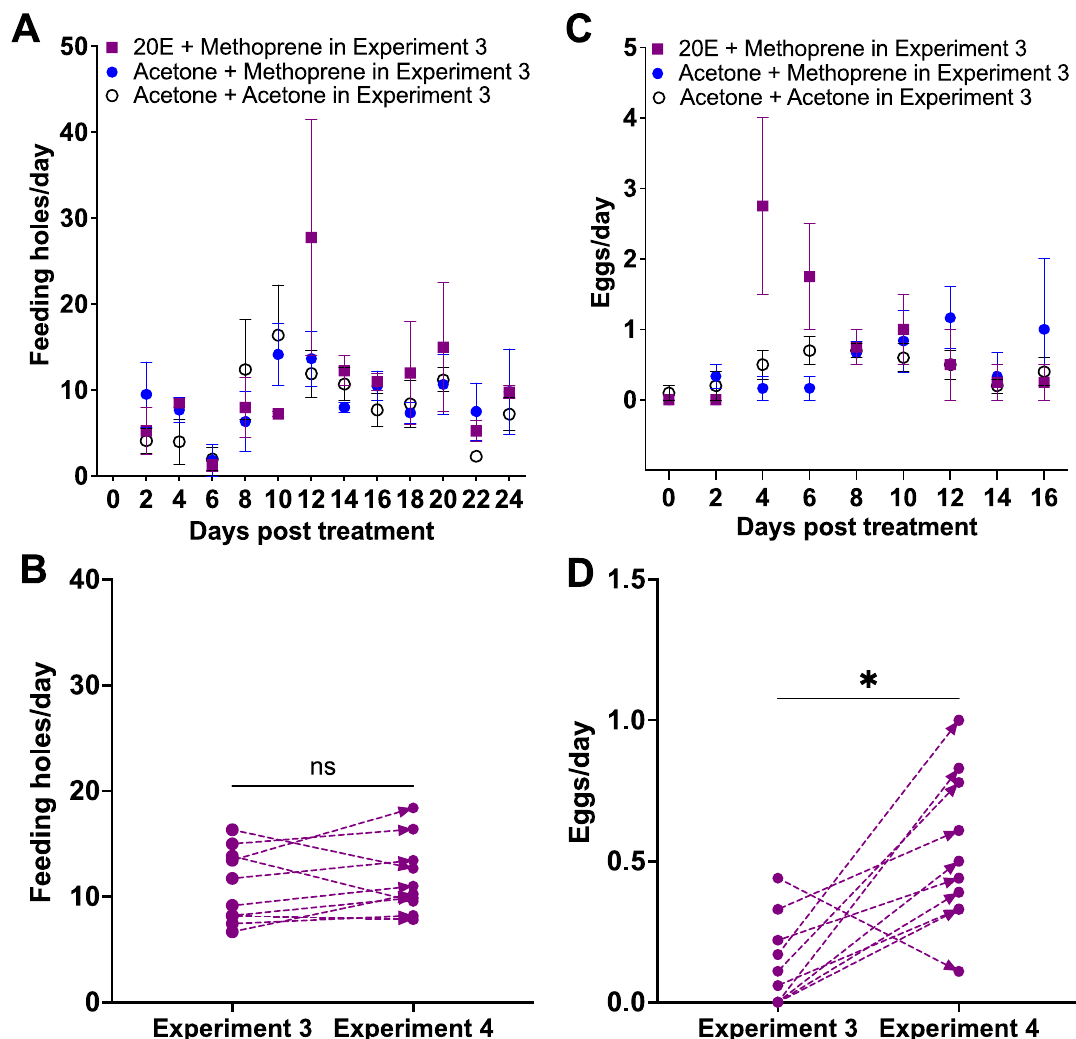
Figure 4. The effect of applying 1 µ g of 20E followed by 1 µ g of methoprene on underperforming (laying < 1 egg per day) and unresponsive females used in Experiment 3 (Figure 3). Daily mean number ± SE of feeding holes ( A ) and individual response of feeding holes for each female weevil ( B ) in Experiment 3 and treated with 20E and methoprene in Experiment 4; daily mean number of eggs ± SE ( C ) and individual response of eggs for each female weevil ( D ); ns: not significant; *: p < 0.05.